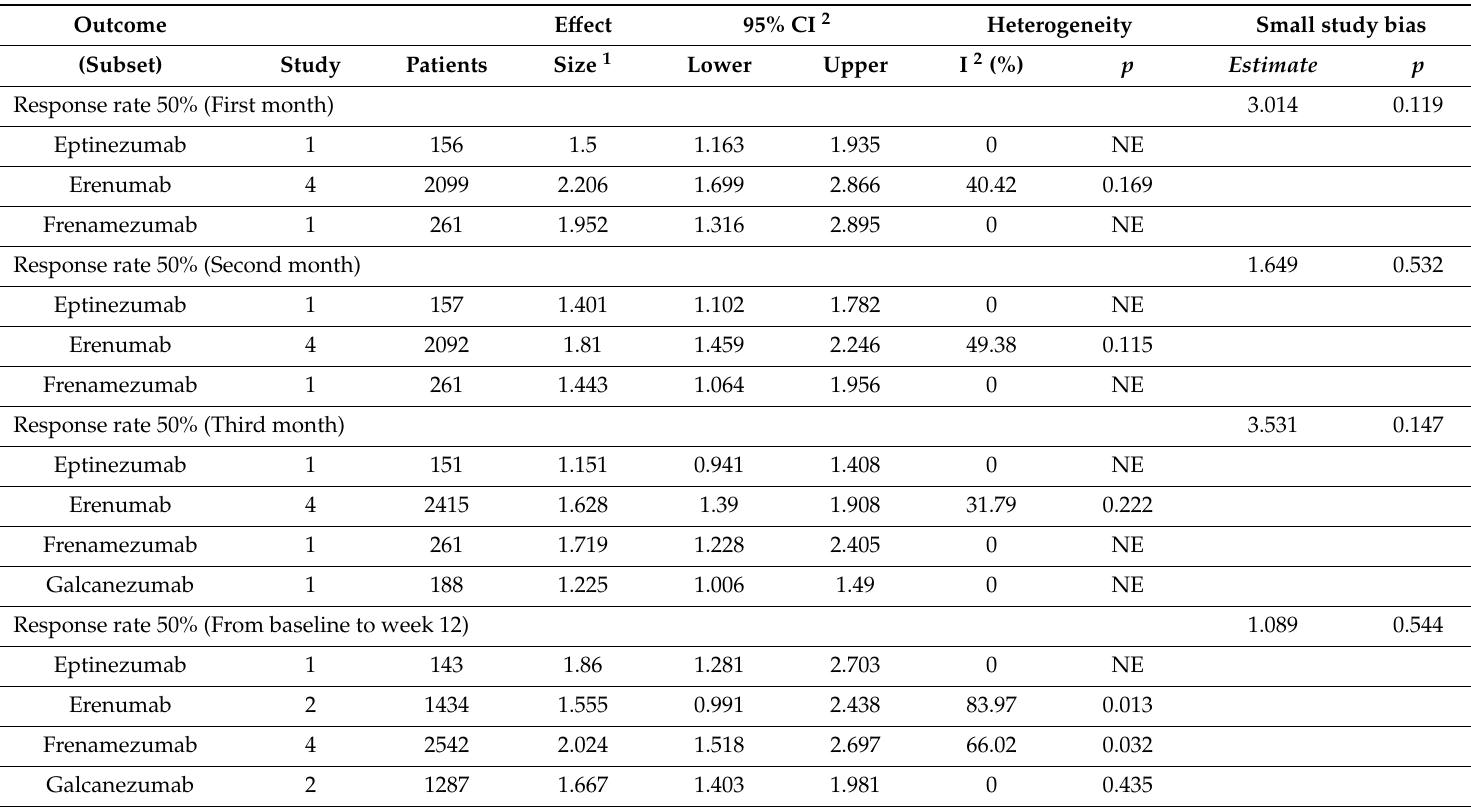
Table 2. Summary of further